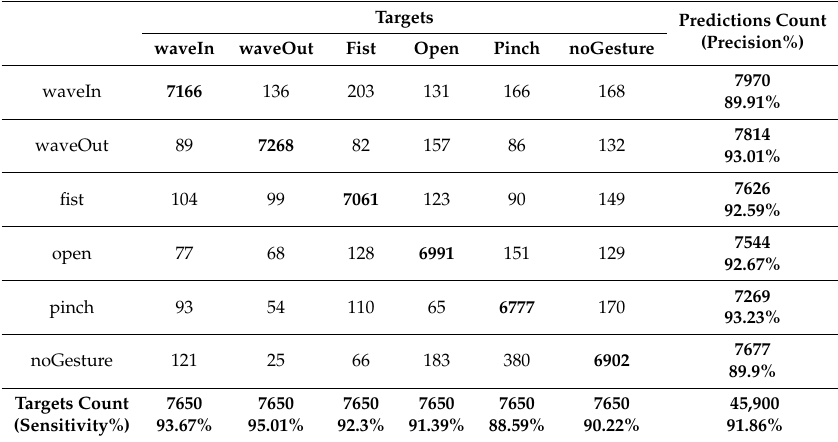
Table A10. Confusion matrix for experiment 4 . Synchronization gestures ( sync = 2 ) .